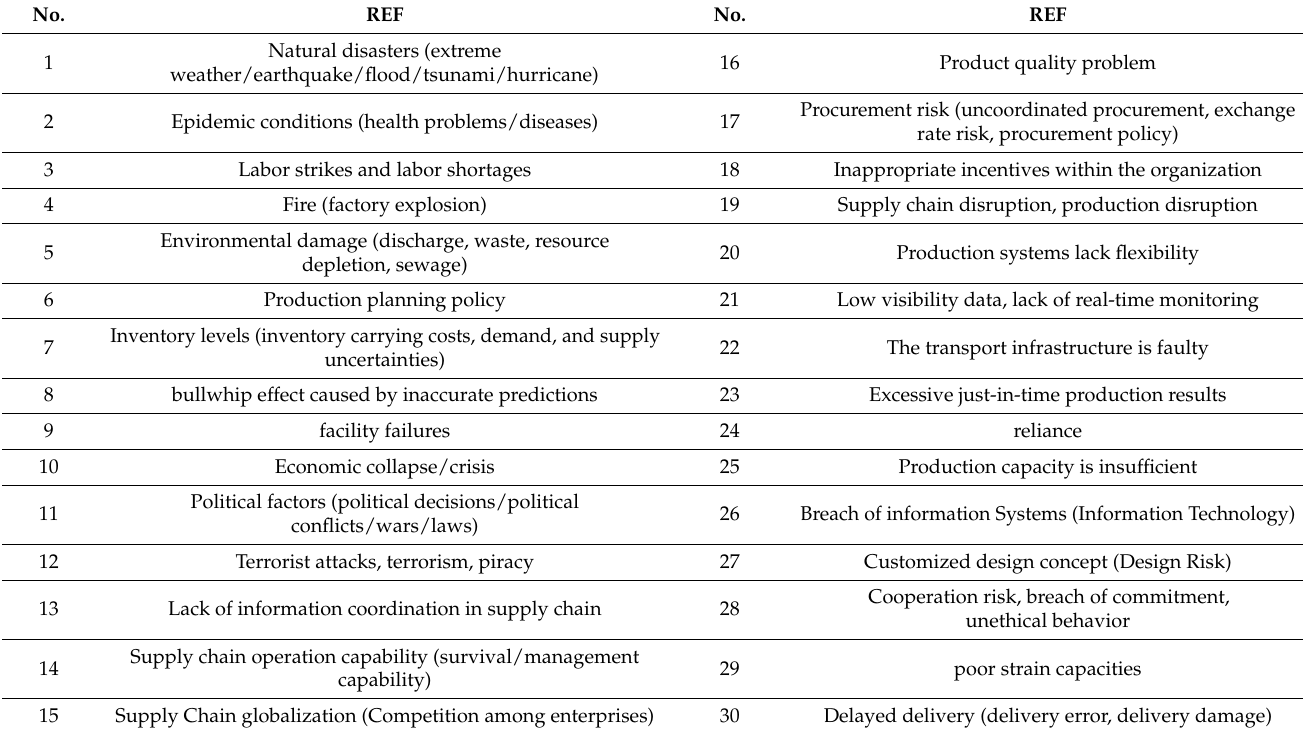
Table 1. REFs screened by KJ